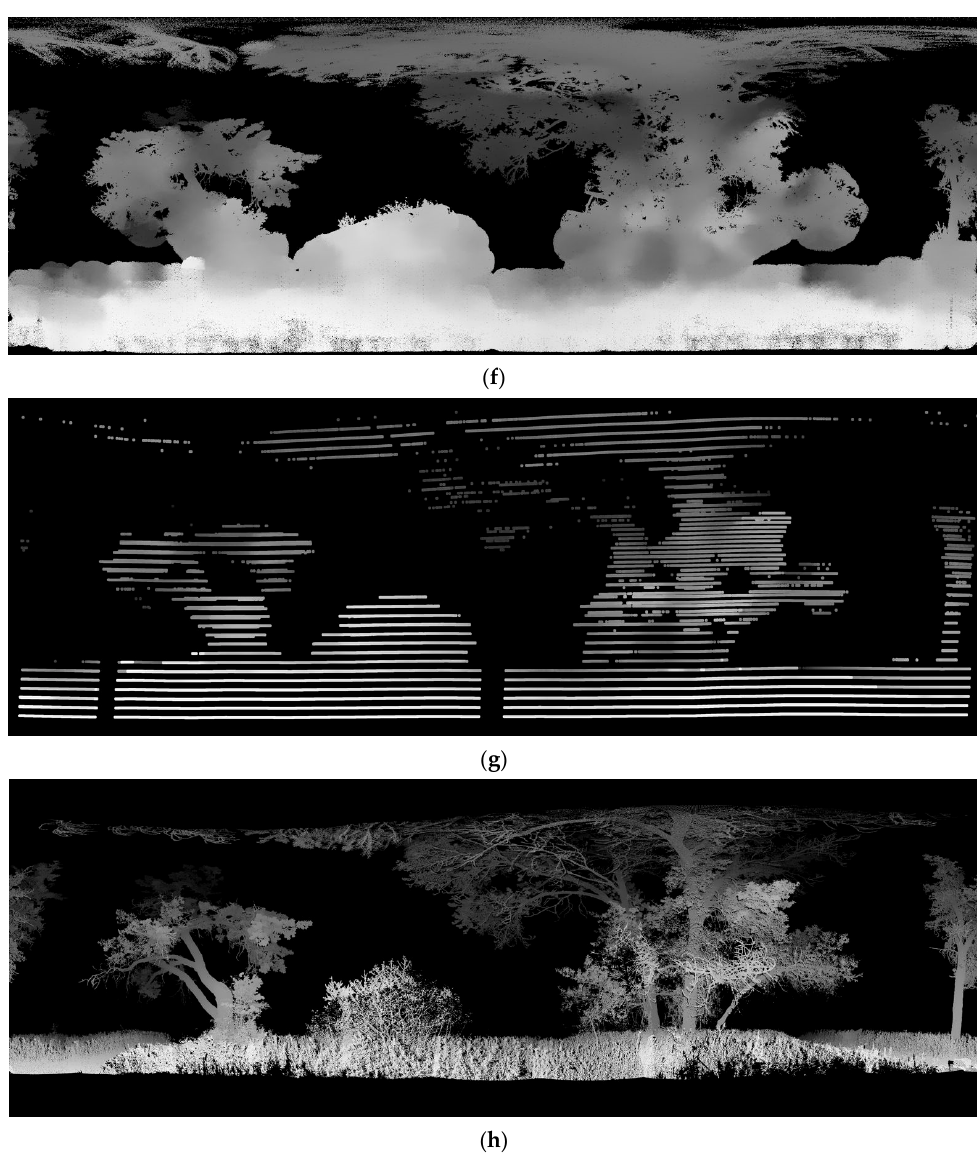
Figure 7. Hemispherical view of processing results: ( a ) image global alignment for the October 1st scan, ( b ) image global alignment for the October 17th scan, ( c ) global alignment layout in PtGUI software with image IDs and seamlines for the October 1st scan, ( d ) Leddar-only point clouds (red cross) reprojected to the hemispherical image, ( e ) RGB colors from fusion-based point clouds, ( f ) depth image from fusion-based RGB point clouds, ( g ) depth image from Leddar-only point clouds (point size enlarged for clearer visualization), and ( h ) the depth image from TLS scans. ( e , f , g , h ) were all done using hemispherical projection. Leddar points were reprojected as the red crosses in Figure 7d and overlaid with the panorama view of the October 1st scene, after applying Leddar intrinsic parameters from the calibration, and camera extrinsic parameters from PtGUI alignment. The Leddar points capture the basic scene structure nearby, except for upper canopy, distant ground, and thin branches. The minimum, average, and maximum detection ranges of Leddar in this scene are 1.64, 6.45, and 14.17 m, respectively. The Leddar point clouds have obvious gaps between the segments and on the ground due to missing signals. This problem of Leddar data sparsity limits potential applications, such as